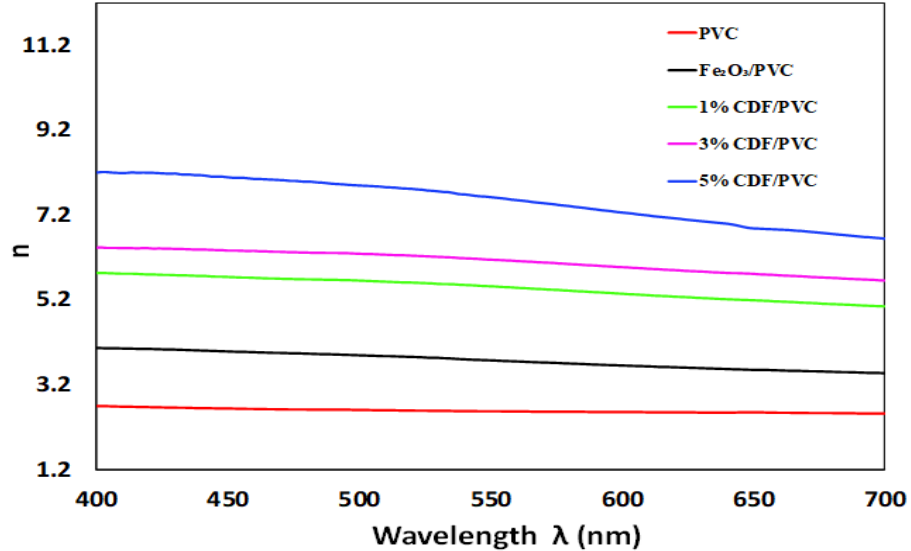
Figure 10. A comparison of the refractive index of PVC and its composites.